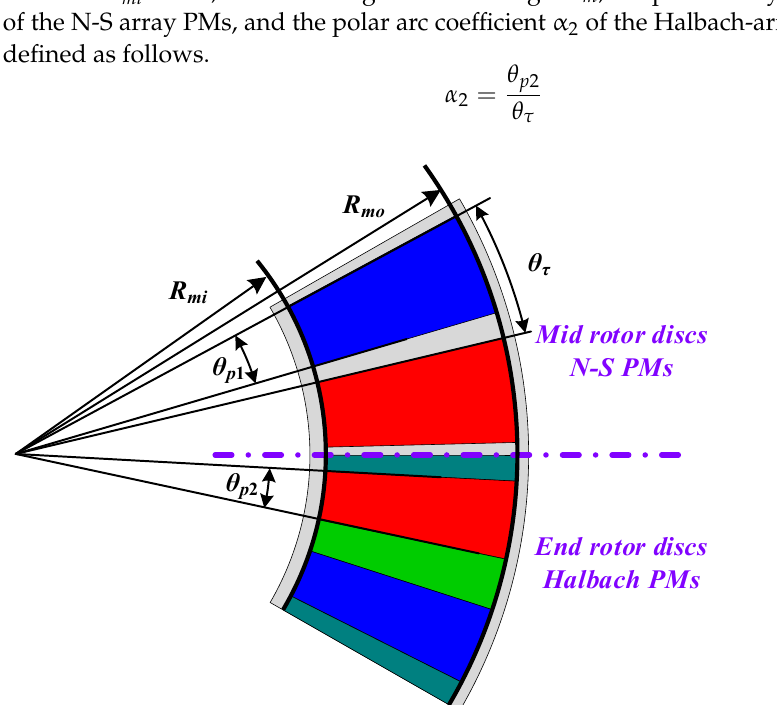
Figure 4. Definition of the parameters in the rotor.